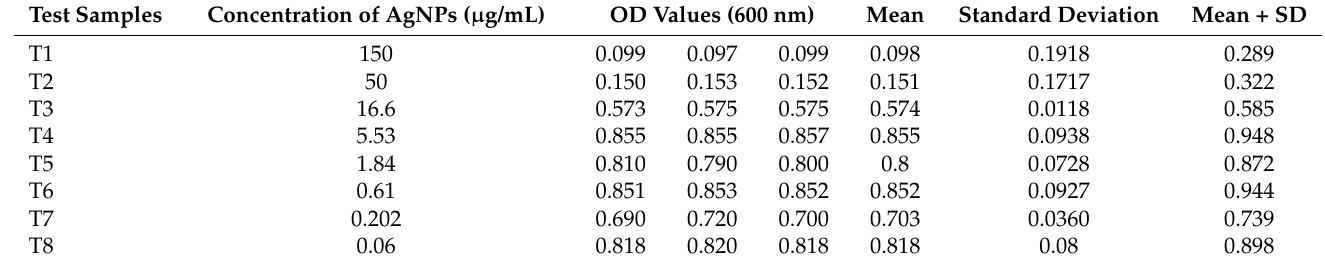
Table 2. Different concentrations of AgNPs were used and their corresponding OD values.